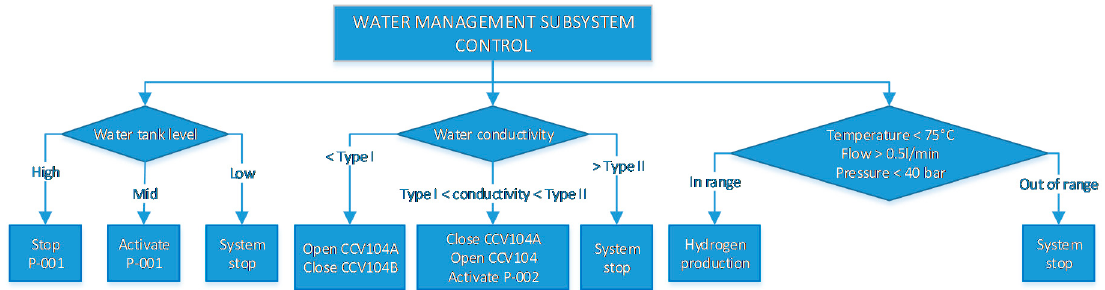
Figure 6. PEM electrolyzer control flow diagram: water management subsystem.